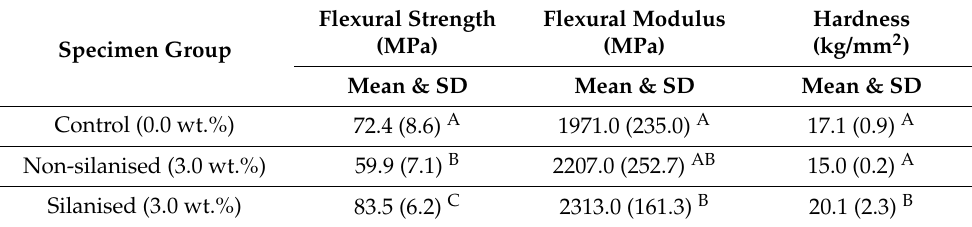
Table 3. Mean and standard deviation (SD) flexural strength, flexural modulus and Vickers hardness values for the test